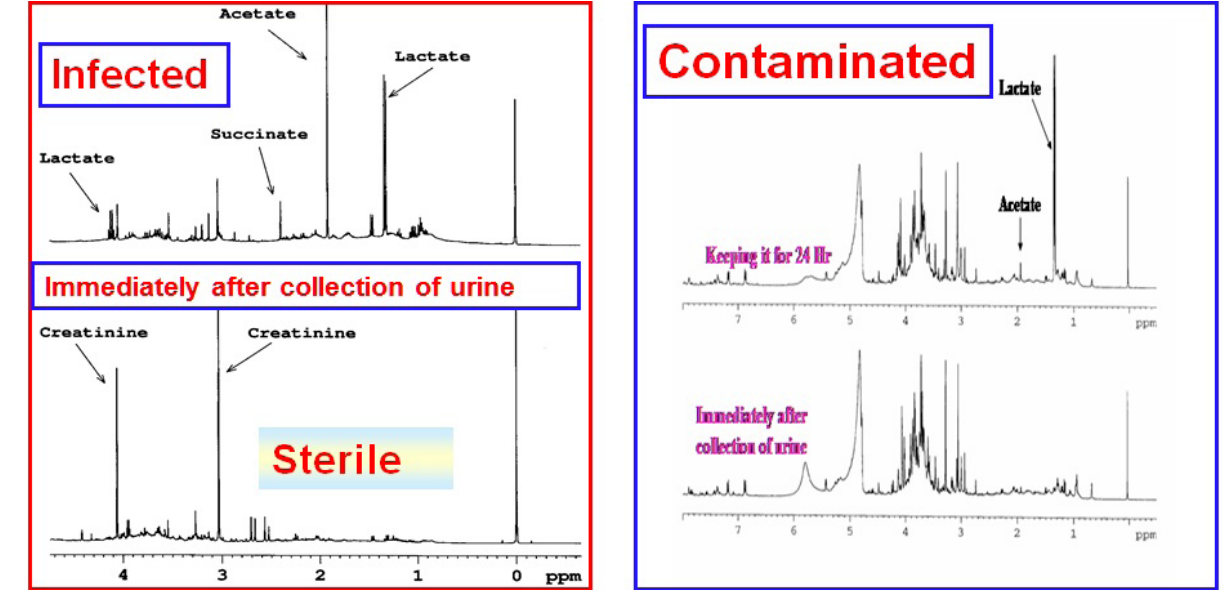
Figure 6. Distinction between real bacterial infection and contamination. Reproduced from Ref. 31 with permission from John Wiley & Sons,